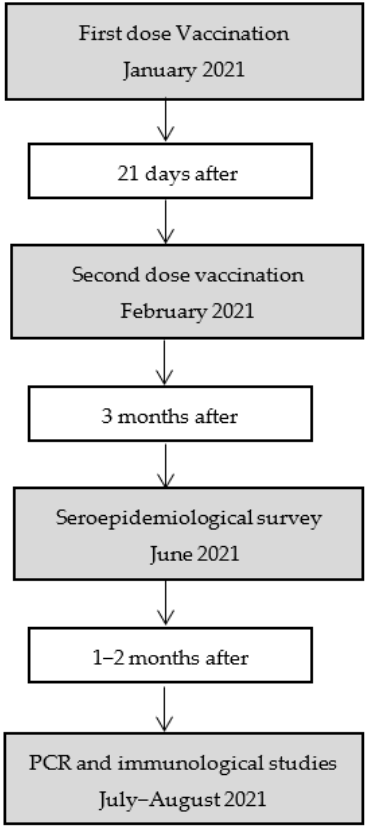
Figure 1. Flowchart of the process of the study.